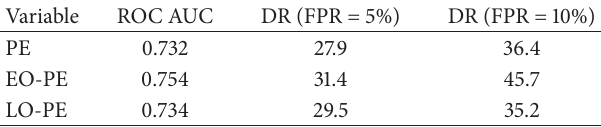
Table 3: Detection rates and ROC results of logistic regression models for prediction of PE, EO-PE, and LO-PE by maternal characteristics and aneuploidy screening biomarkers.